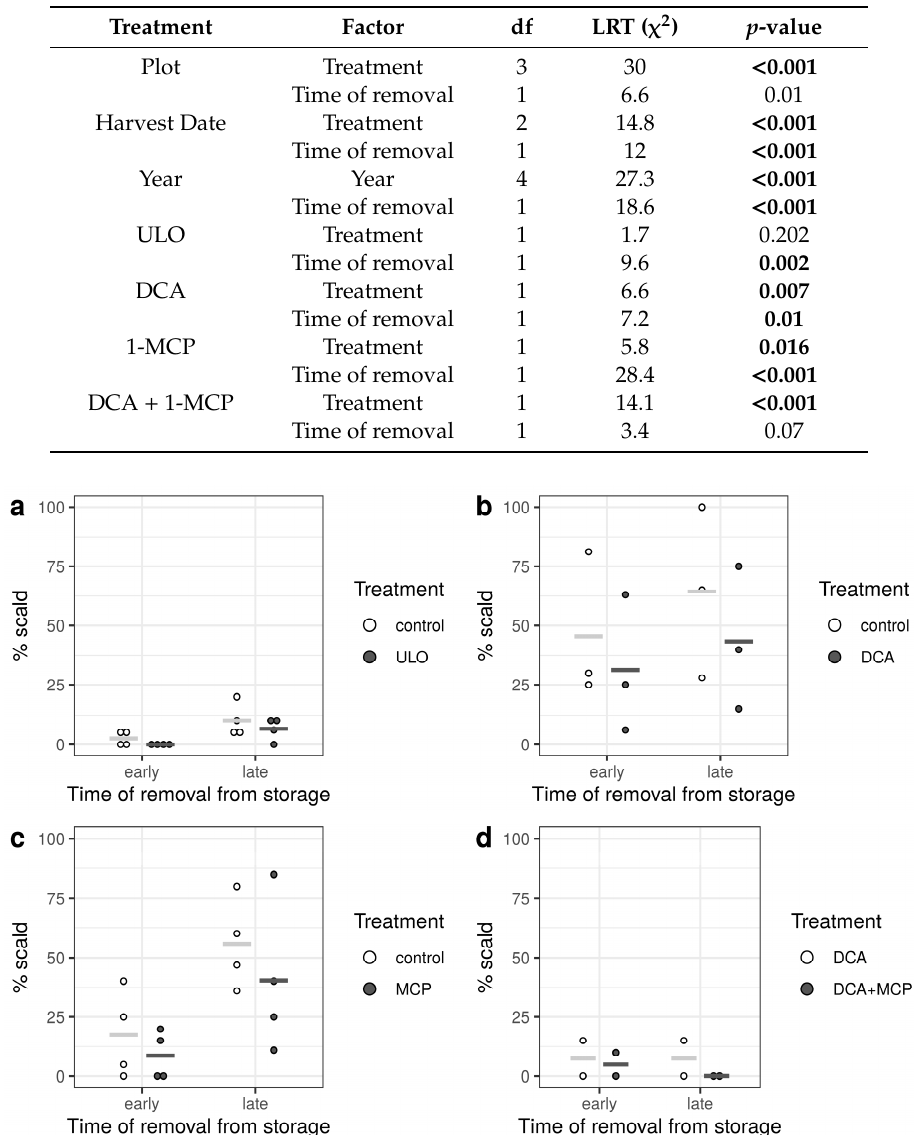
Table 2. Results of generalized linear models (family = binomial) comparing the occurrence of superficial scald between various treatments (1-MCP treatment, ultralow oxygen treatment, and DCA treatment) and the respective control, as well as the comparison between di ff erent harvest times, years, and locations within the control treatments, df = degree of freedom. Significance values ( p < 0.05) for fixed e ff ects were determined using LRT (Chi-squared) and are listed below in bold.